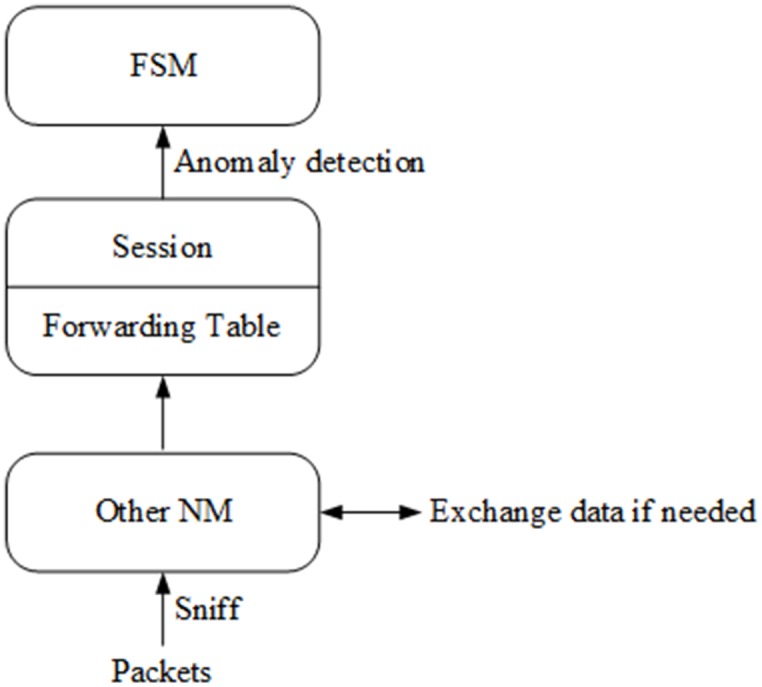
Network monitor.